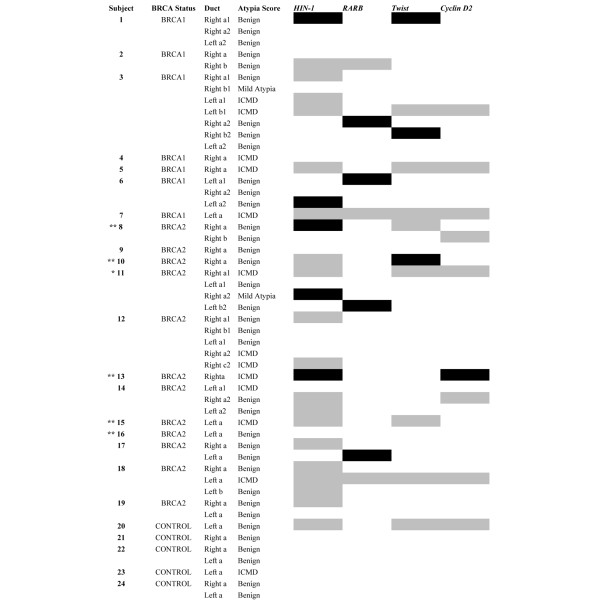
Methylation analysis of four-gene panel in DL fluid from BRCA1 and BRCA2 carriers and controls. The genes in the panel were HIN-1, RAR-β, Twist and Cyclin D2. Ducts are identified as being from the left or right breast. Individual ducts are identified sequentially as a, b or c. The suffix 1 or 2 indicates the first or second lavage visit, respectively, for ducts from which repeat samples were taken 1 year apart. For example, left a2 indicates that a sample was taken from the left breast, duct a at the second ductal lavage (DL) visit. Black boxes indicate methylated genes, white boxes indicate unmethylated genes, and grey boxes indicate repeated failure of PCR reaction or inconclusive result. *Subject 11 had long-standing atypia identified in both breasts on nipple aspirate fluid cytology. **BRCA2 carriers affected by contralateral breast cancer. DL samples were collected from only their healthy unaffected breasts. ICMD, insufficient cellular material for diagnosis.